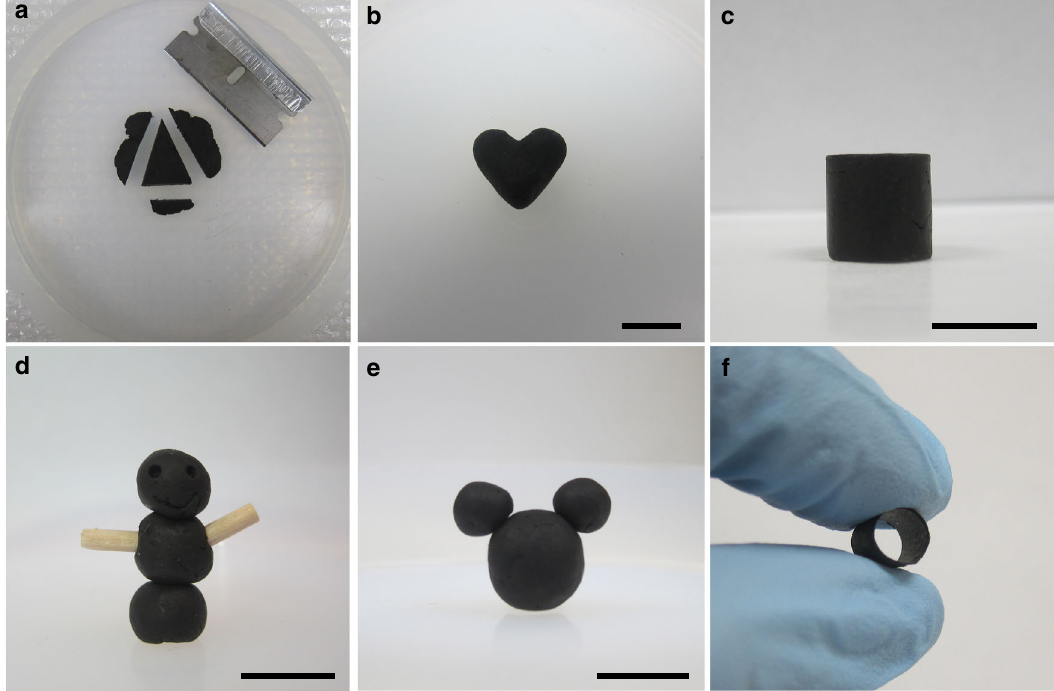
Fig. 3 GO doughs are highly processable and versatile. GO doughs can be readily reshaped by a cutting, b pinching, c molding, and d carving. GO doughs can be easily connected together d , e or with other solid materials d using the wooden sticks as an example. f A tubular GO structure can be prepared by molding a GO dough around a rod, demonstrating the versatility of using GO doughs to make 3D architectures that are otherwise challenging to obtain. Scale bars in b , c , d , and e are 1